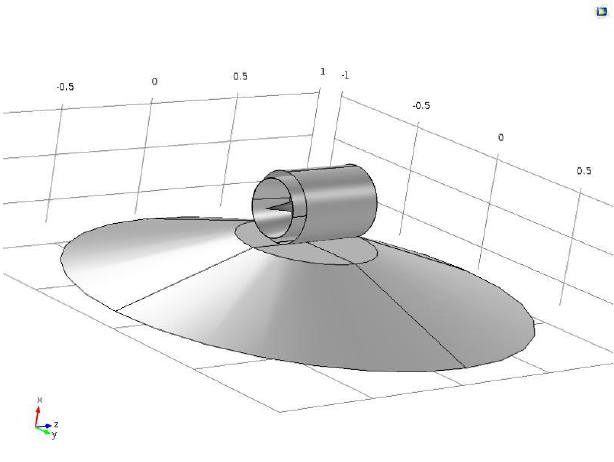
Figure 3. Estimated grid for one of model of the